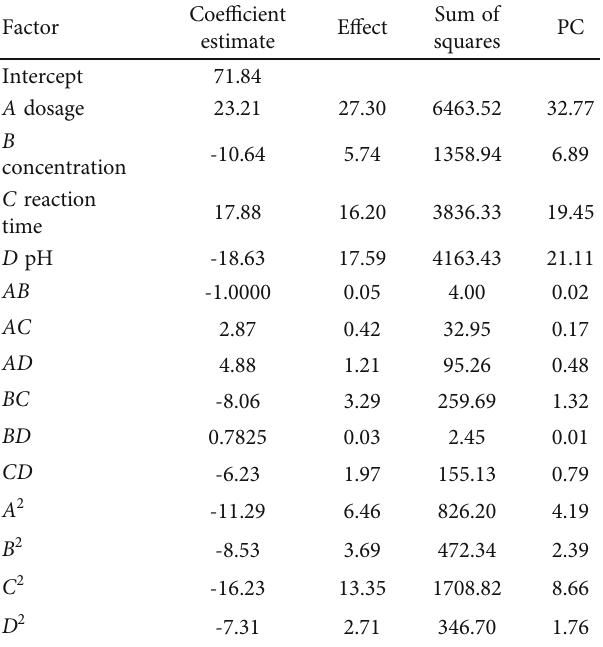
Table 4: Multiple regression consequence of the terms for the quadratic